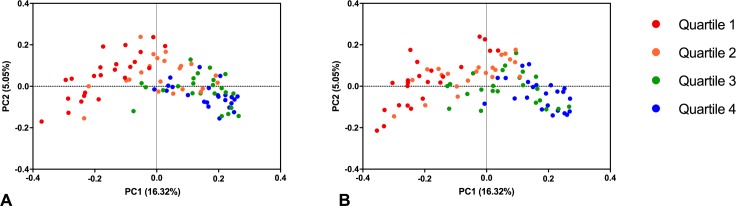
Principal coordinates analysis (PCoA) of subjects at time of ICU admission (A) and 72 hours later (B), stratified by relative abundance Clostridial Clusters IV and XIVa. There was distinct clustering of subjects based on levels of Clostridial Clusters IV and XIVa both at ICU admission and 72 hours later even though these Clostridia made up <1% overall relative abundance of the fecal microbiome. Taxa included in Cluster IV/XIVa: F. prausnitzii, Blautia, Coprococcus, Roseburia, and Ruminococcus. Subjects are color-coded by pooled levels of Cluster IV/XIVa Clostridia, from the lowest relative abundance (Quartile 1) to the highest relative abundance (Quartile 4).